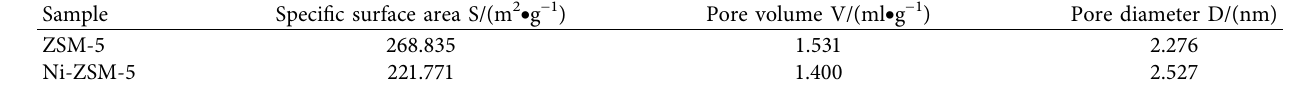
Table 3: Pore structure parameters of ZSM-5 and Ni-ZSM-5 catalysts.